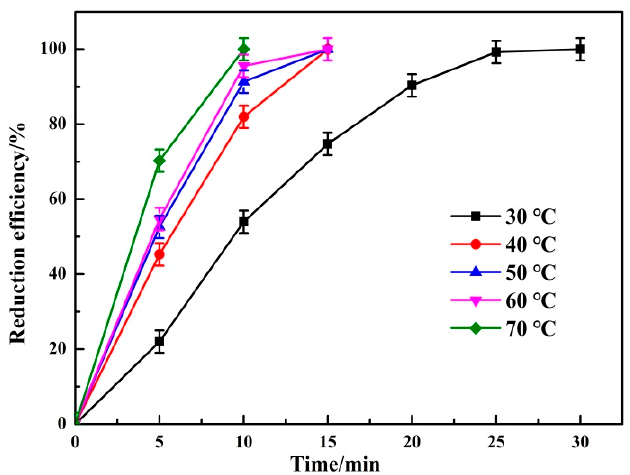
Figure 3. Effect of reaction temperature on reduction efficiency of chromium. ( Volume of H 2 SO 4 = 0.50 mL, initial concentration of Cr (VI) = 1.000 g/L, Current intensity = 0.05 A).